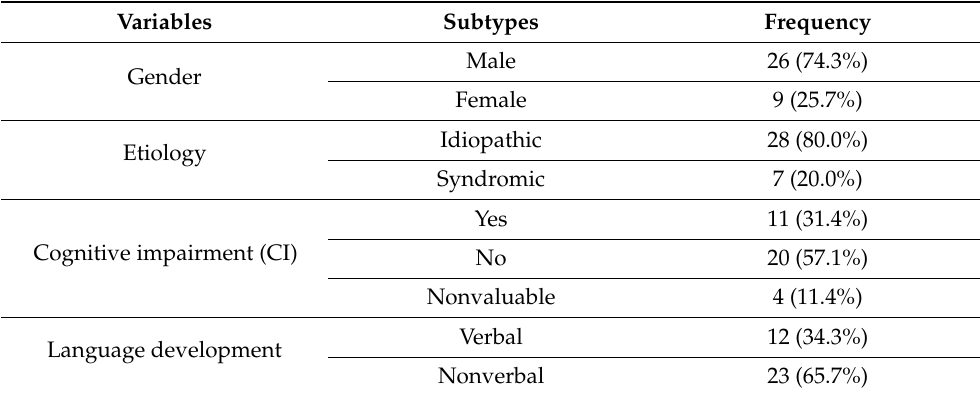
Table 1. Demographic and main clinical variables of the sample.